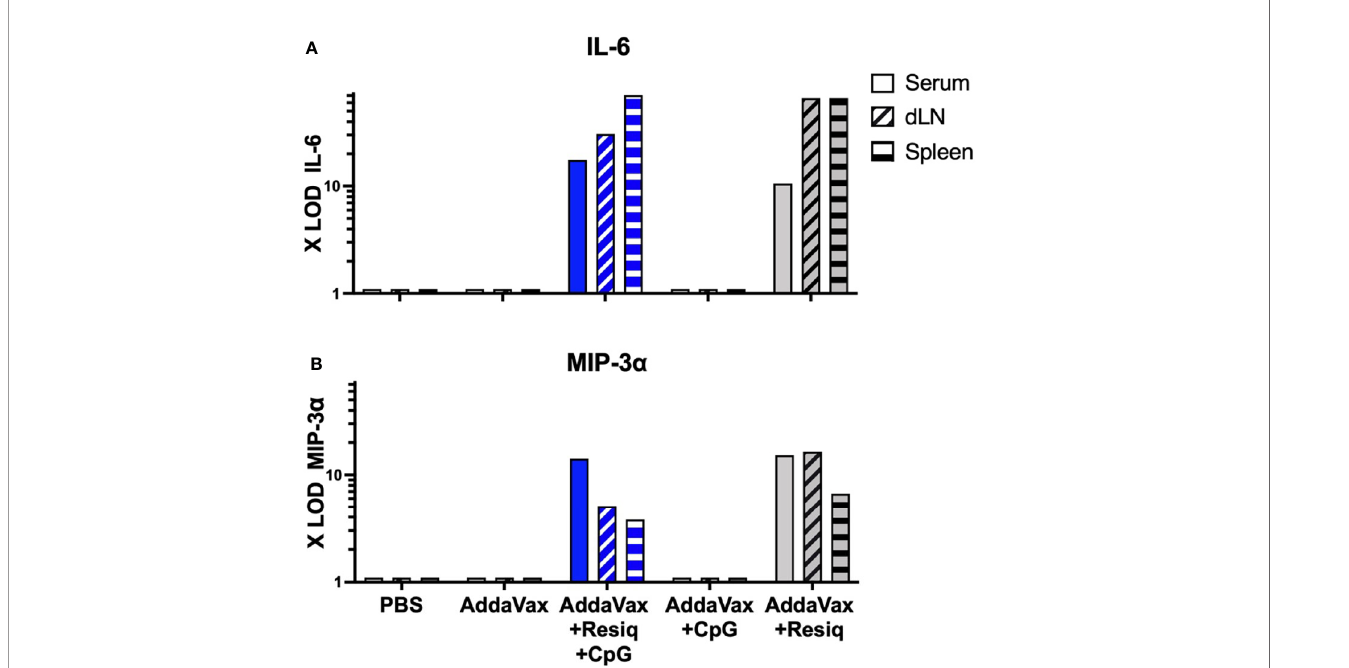
FIGURE 4 | Cytokines/chemokines detectable by microarray at 4h post SS prime. Serum and extracts of spleen or dLN collected at 4h post SS from 3-4 mice/ group were tested for levels of cytokines/chemokines by microarray. IL-6 (A) and MIP-3 a (B) were detected in serum (solid blue bar) and extracts of spleen and dLN (hatched blue bars) obtained from mice immunized with AddaVax + Resiquimod + CpG, but not Addavax only or PBS. Induction of IL-6 and MIP-3 a was primarily due to inclusion of Resiquimod (gray bars). All samples were negative (<3X LOD) for IL-1 b , IL-2,-3,-5,-10, IL-12p70, IL-13,-17,-17F,-21,-23,-28, IFN g , TGF b 1 and TNF a when tested by